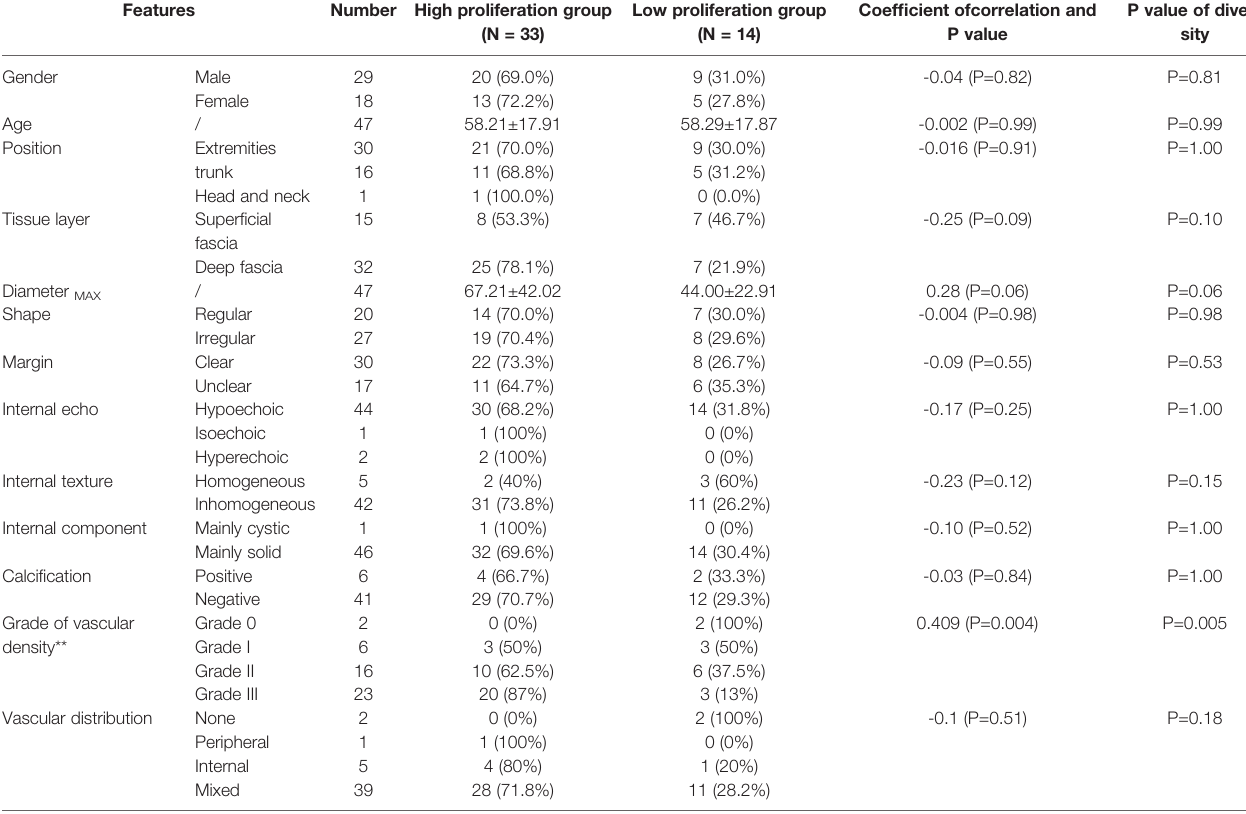
TABLE 2 | Characteristics of soft tissue sarcomas.